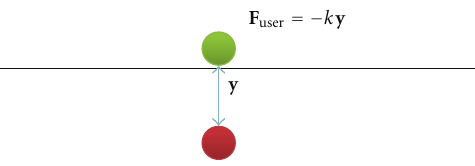
Figure 2: Conceptual representation of haptic rendering. k deter- mines the sti ff ness of the surface and y the penetration distance between the haptic probe (red circle) and its projection on the surface border (green